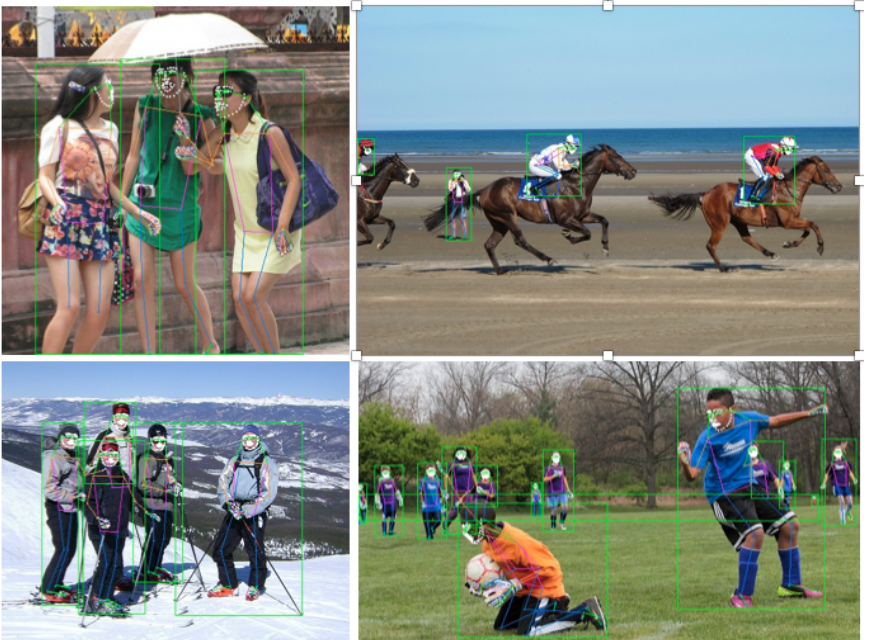
Figure 6. Pose estimation results using Full-BAPose with the COCO-WholeBody